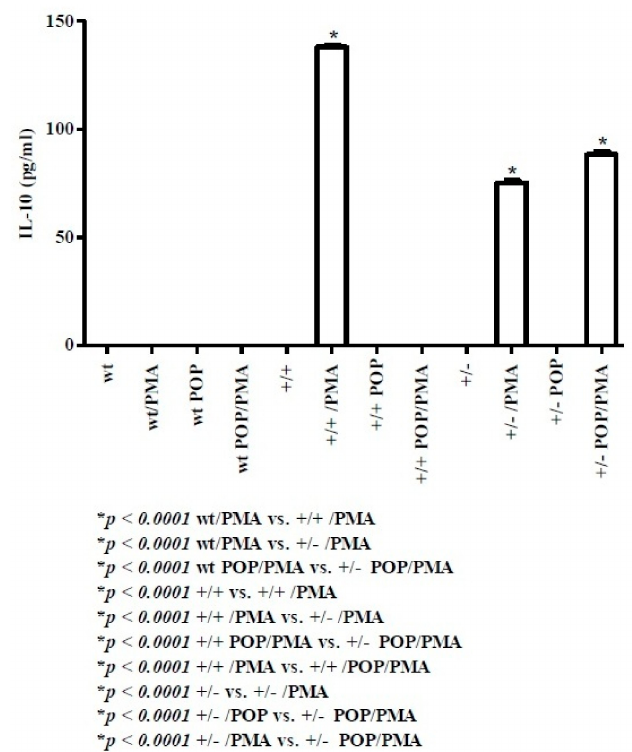
Figure 5. Levels of IL-10 in splenic supernatants from cell cultures of postnatal day 8 pups. For methods, abbreviations, and statistical analysis, see Figures 1 and